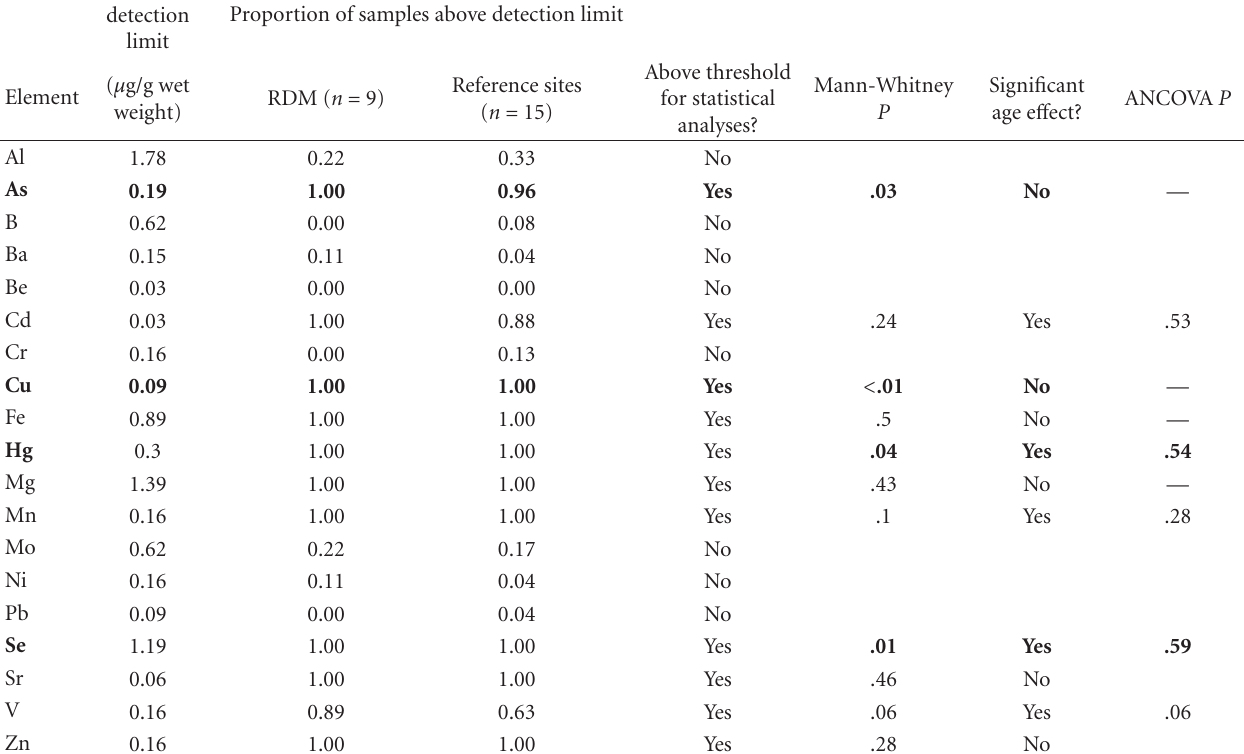
Table 2: Statistical comparisons of trace element concentrations in bearded seal liver tissue between Red Dog Mine port site (RDM) and reference sites. No statistical tests were conducted when trace elements were detected in less than 50% of samples. ANCOVA was used to control for possible age e ff ects when the nonparametric Mann-Whitney test identified di ff erences in trace metals concentrations between RDM and reference samples. Trace elements detected in more than 50% of samples that Mann-Whitney tests identified as statistically di ff erent between RDM and reference sites are in